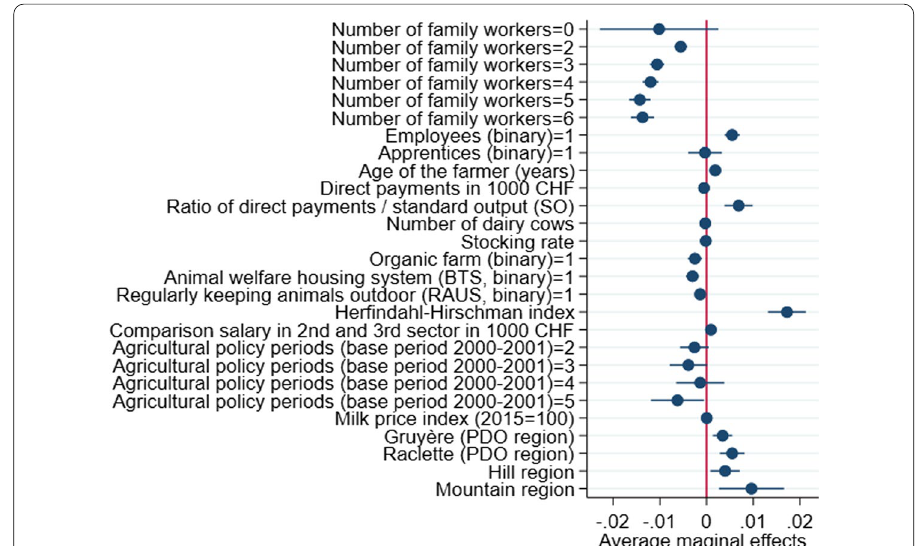
Fig. 2 Plots of average marginal effects of the logistic regression for the probability of a farm exit. Notes : Point estimates with lines illustrating the 95% confidence